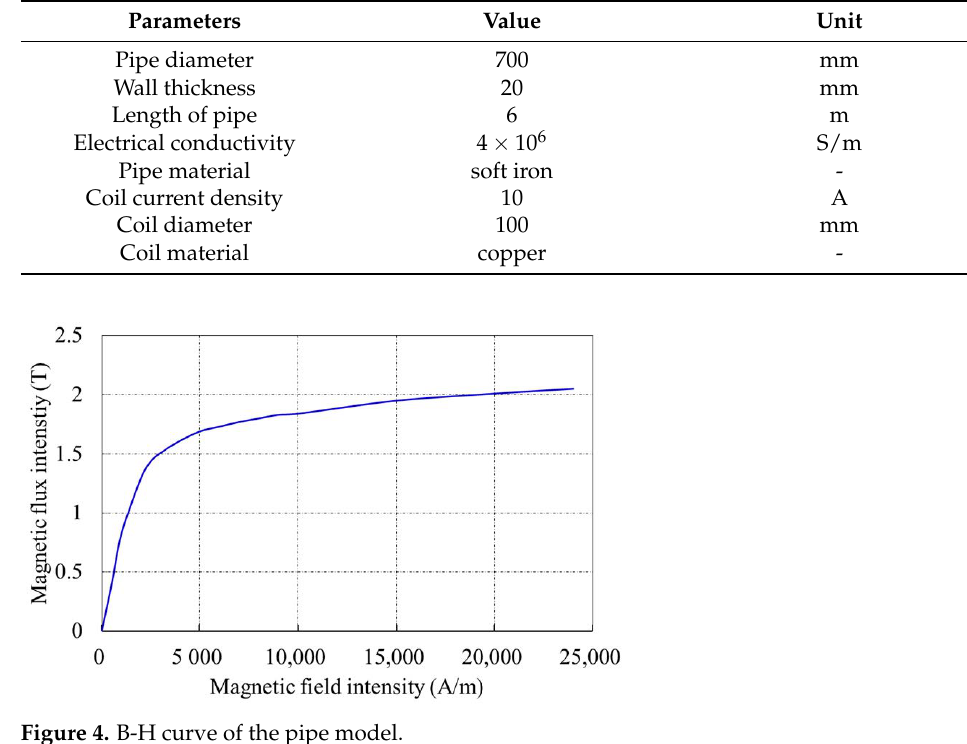
Figure 4. B-H curve of the pipe model.